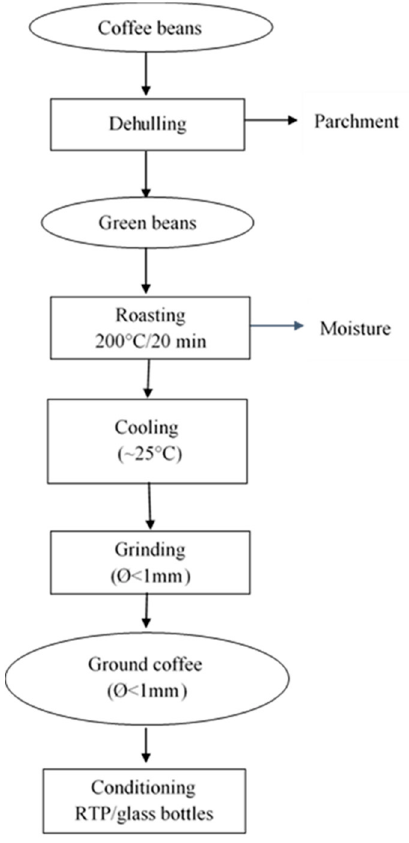
Figure 6. Processing of coffee beans.